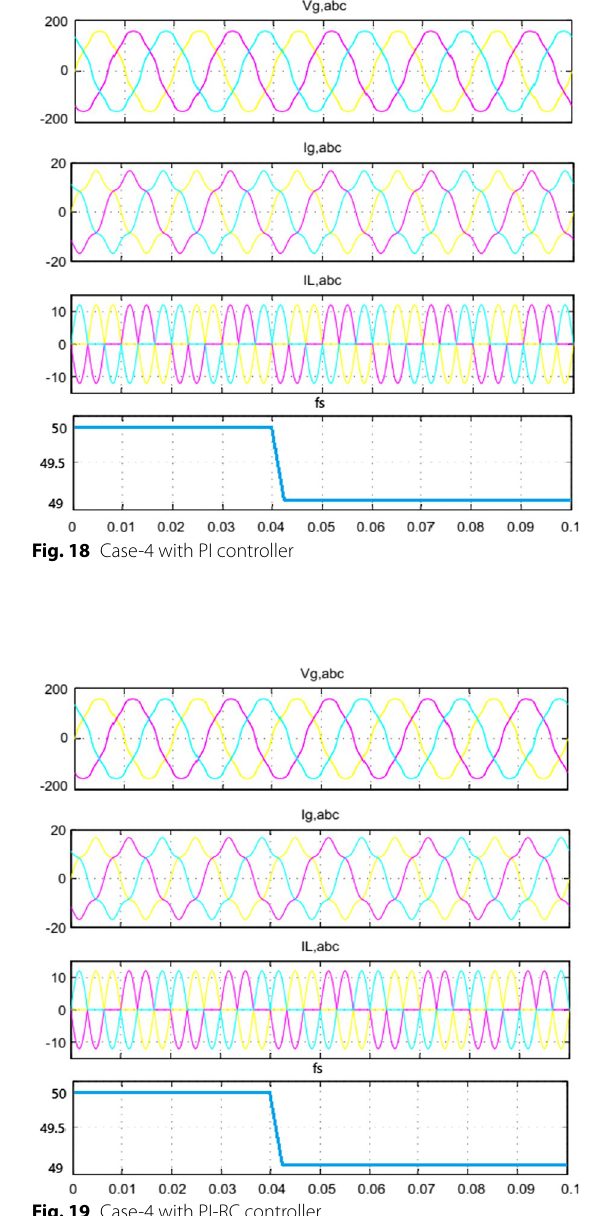
the distorted grid voltage. DG with PI, PI-RC and